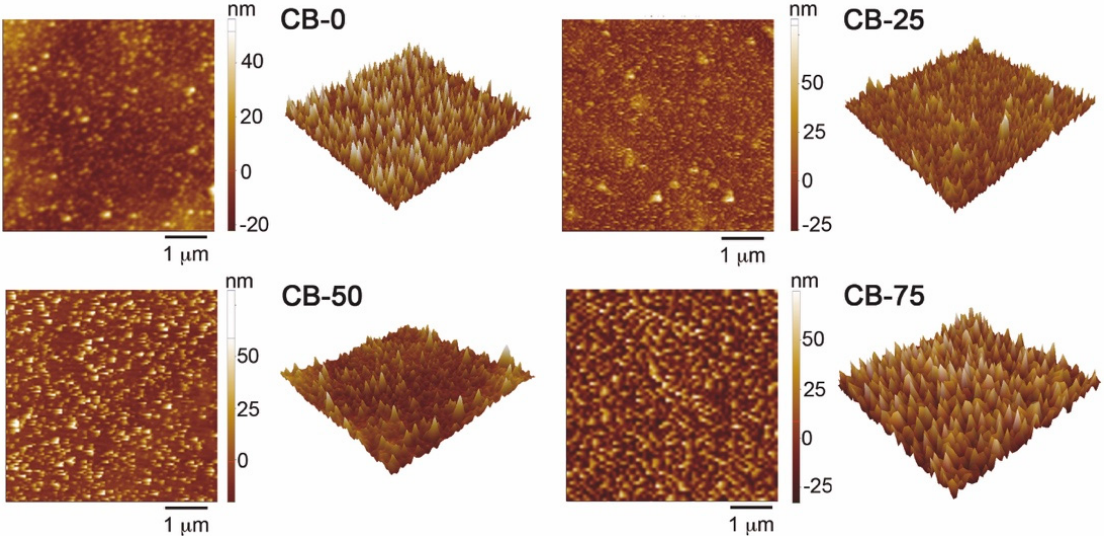
Figure 2. 2D and 3D surface topography of CB-0 , CB-25 , CB-50 , and CB-75 . The hydrophobic and hydrophilic characteristics of brush gels were determined using water contact angle measurements. While the contact angle of the RAFT agent bonded surface was 65 ◦ [42], the brush gels’ water contact angle after polymerization was determined to be 42 ± 3 ◦ , 47 ± 5 ◦ , 49 ± 6 ◦ , and 52 ± 4 ◦ for CB-0 , CB-25 , CB-50 , and CB-75 , respectively. After strong chlorination, the water contact angle of cross-linked polymer brushes containing N -halamine significantly decreased to approximately 39 ± 4 ◦ ; however, no significant change was observed in the water contact angle measurements of the N -halamine- free control surface ( CB-0 ). Water contact angle measurements were repeated over three recharge–discharge cycles to investigate the reusability of the surfaces, and the cross- linked polymer brushes can still be reused after recharge (Figure 3).